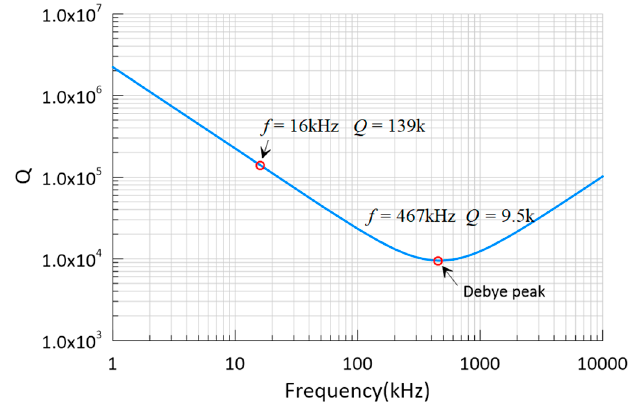
Q Figure 3. Q TED of an 18 µ m wide beam at di ff erent frequencies. Figure 3. TED of an 18 μ m wide beam at different frequencies.